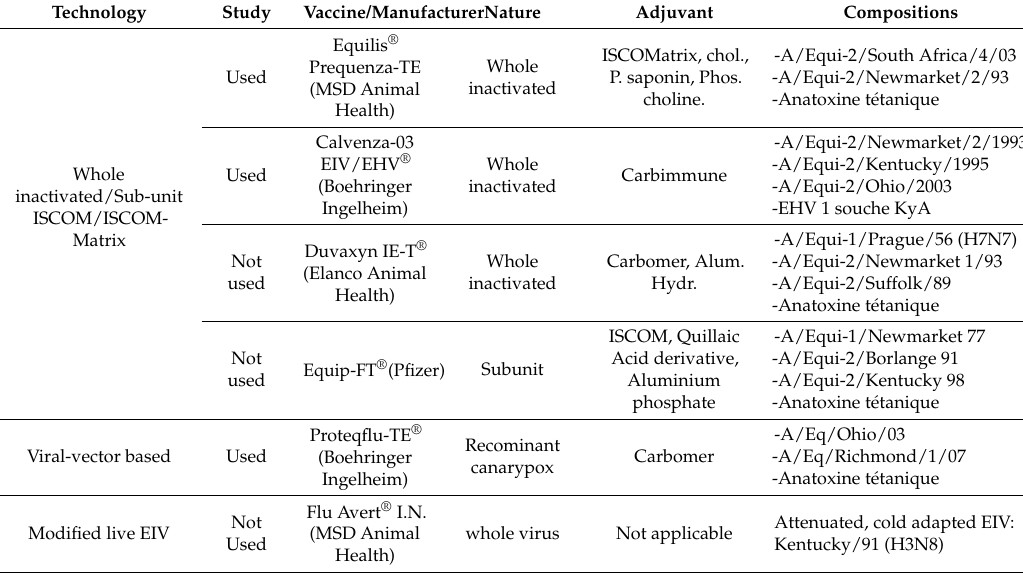
Table 1. Equine Influenza vaccines classed by